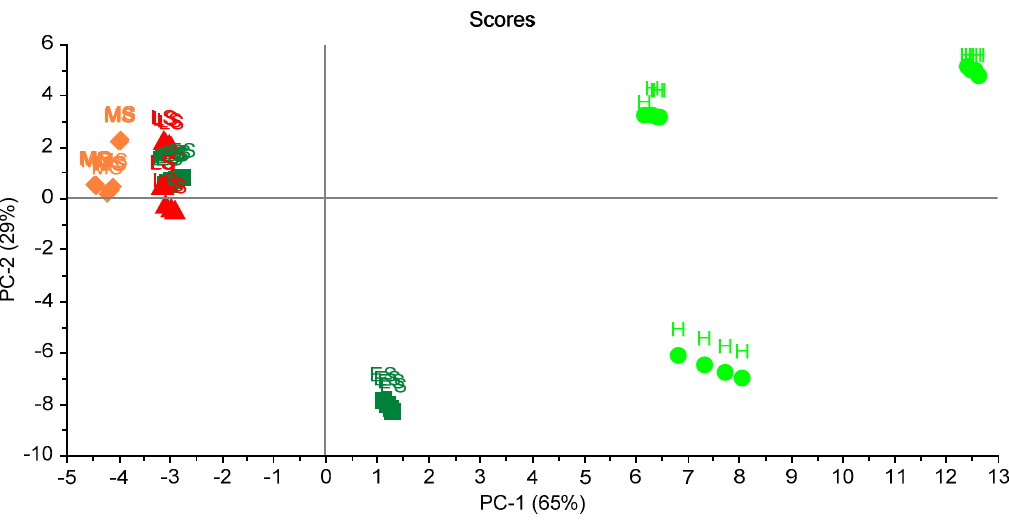
Figure 10. Scores plot of the 16 samples in the three trials. A clear separation between health samples is shown. Healthy sample (H), infected early-stage (ES), infected moderate-stage (MS), and infected late-stage (LS).